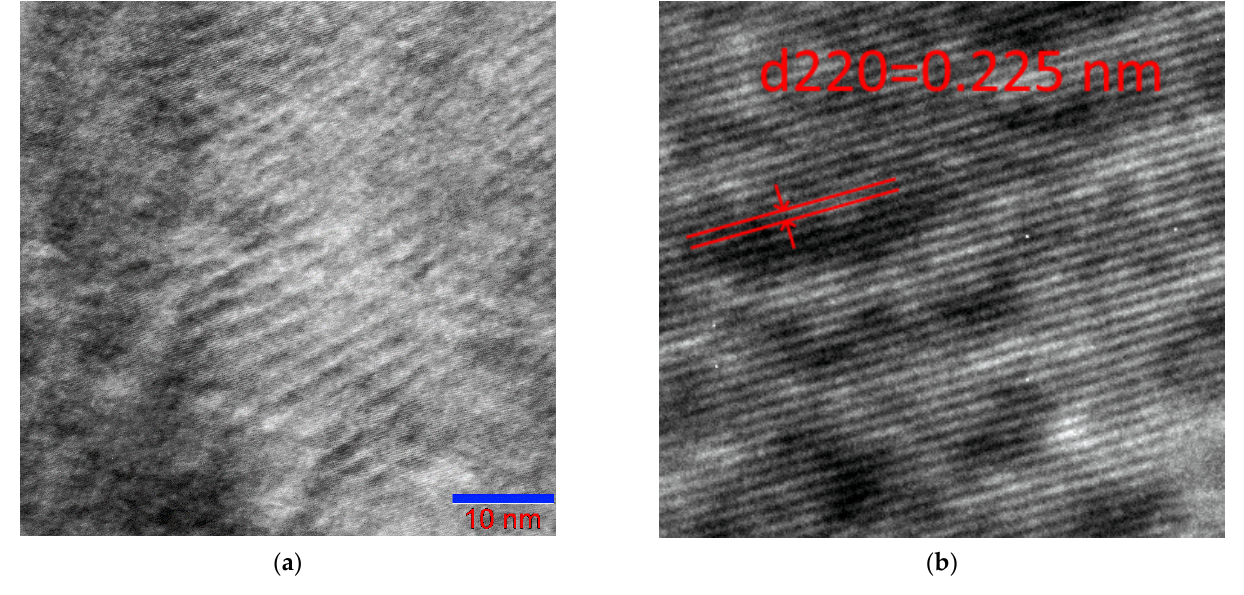
Figure 7. High resolution photomicrographs from the tweed texture area of the Ni 46 Mn 41 In 13 alloy in the austenitic state at room temperature ( a ) and selected enlarged fragment of the photo ( b ).